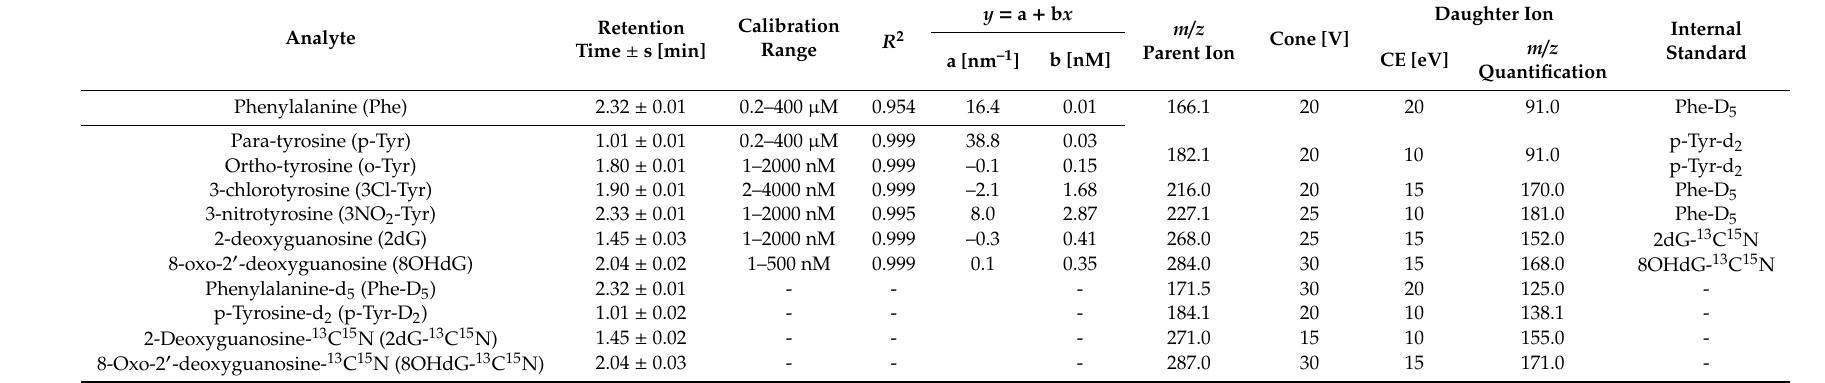
Table 1. Analytical parameters and figures of